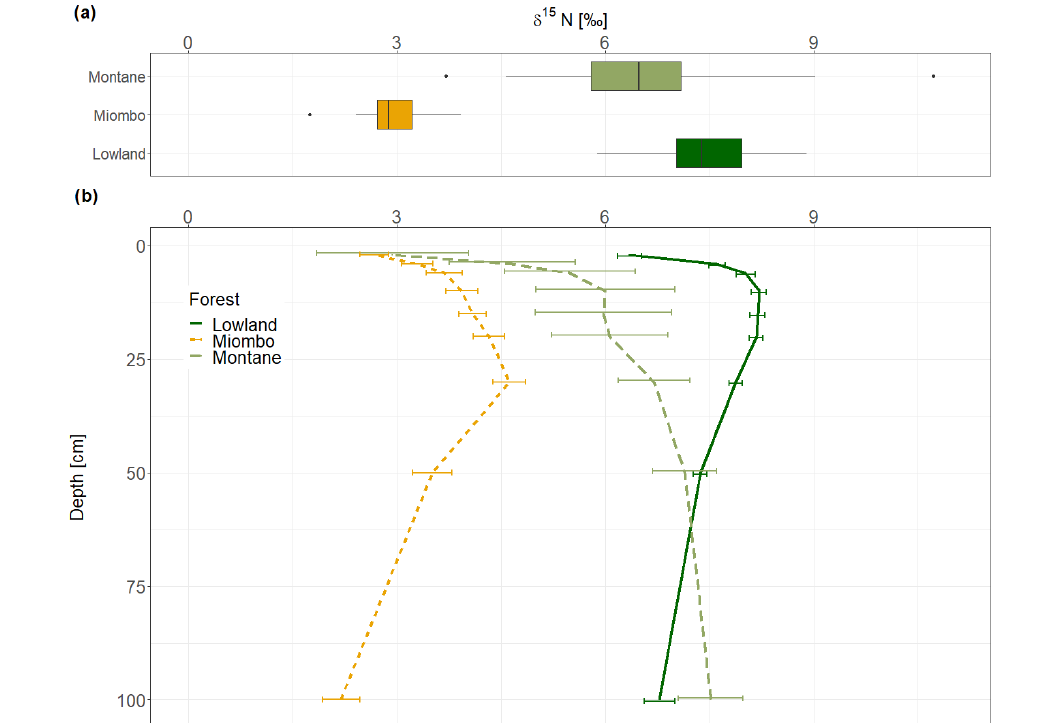
Figure 2. (a) Boxplots of the δ 15 N of the topsoil (0–20cm) samples from the montane, lowland, and Miombo forest sites. (b) δ 15 N profiles from the different forest types. Lines showing the means of the replicates from one sampling site. Error bars indicating standard